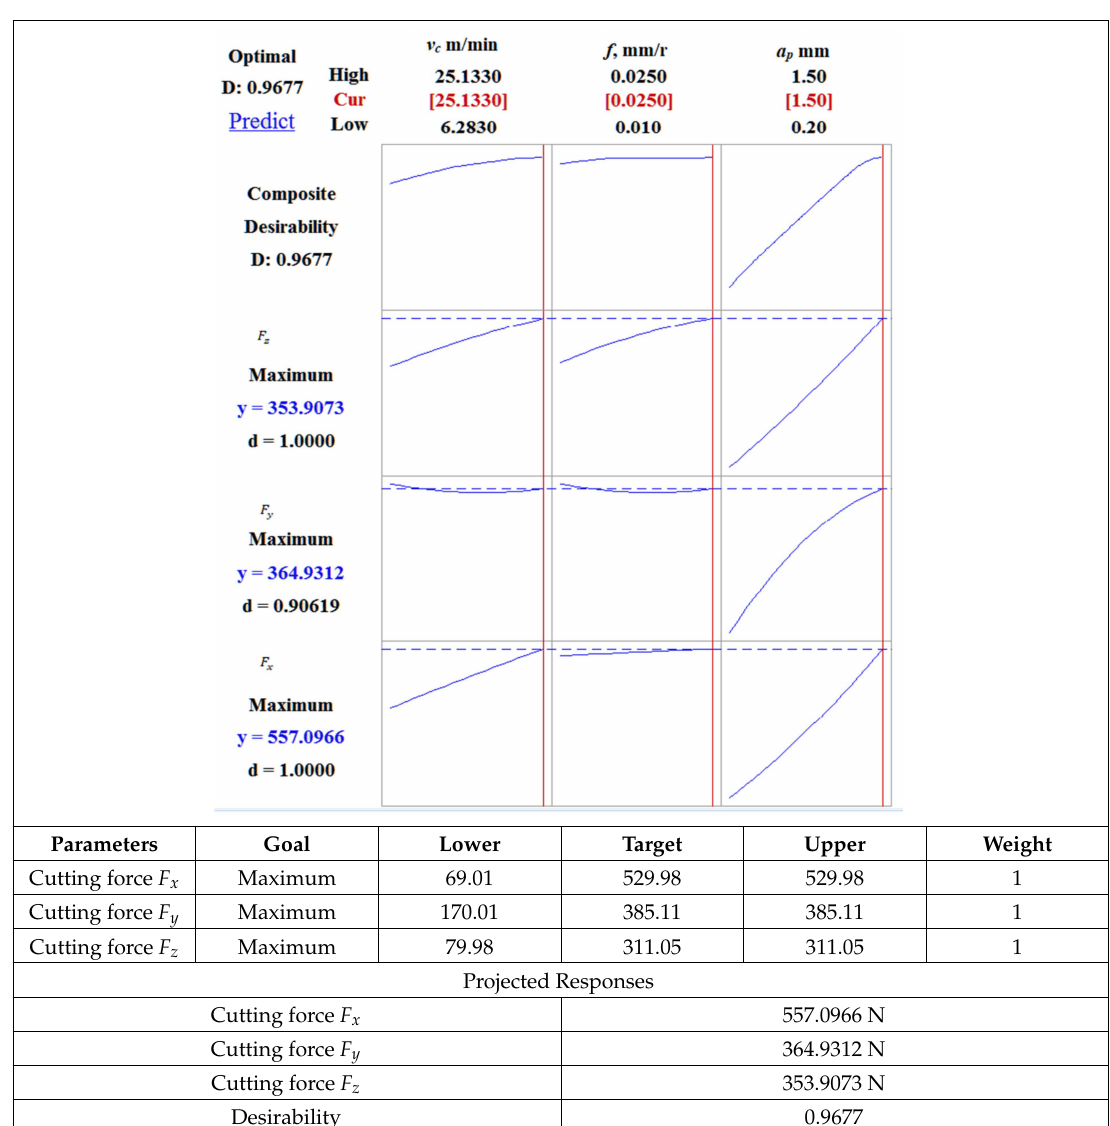
Figure 12. Optimization Plot for Maximum Cutting Force of F x , F y , F z SiCp /